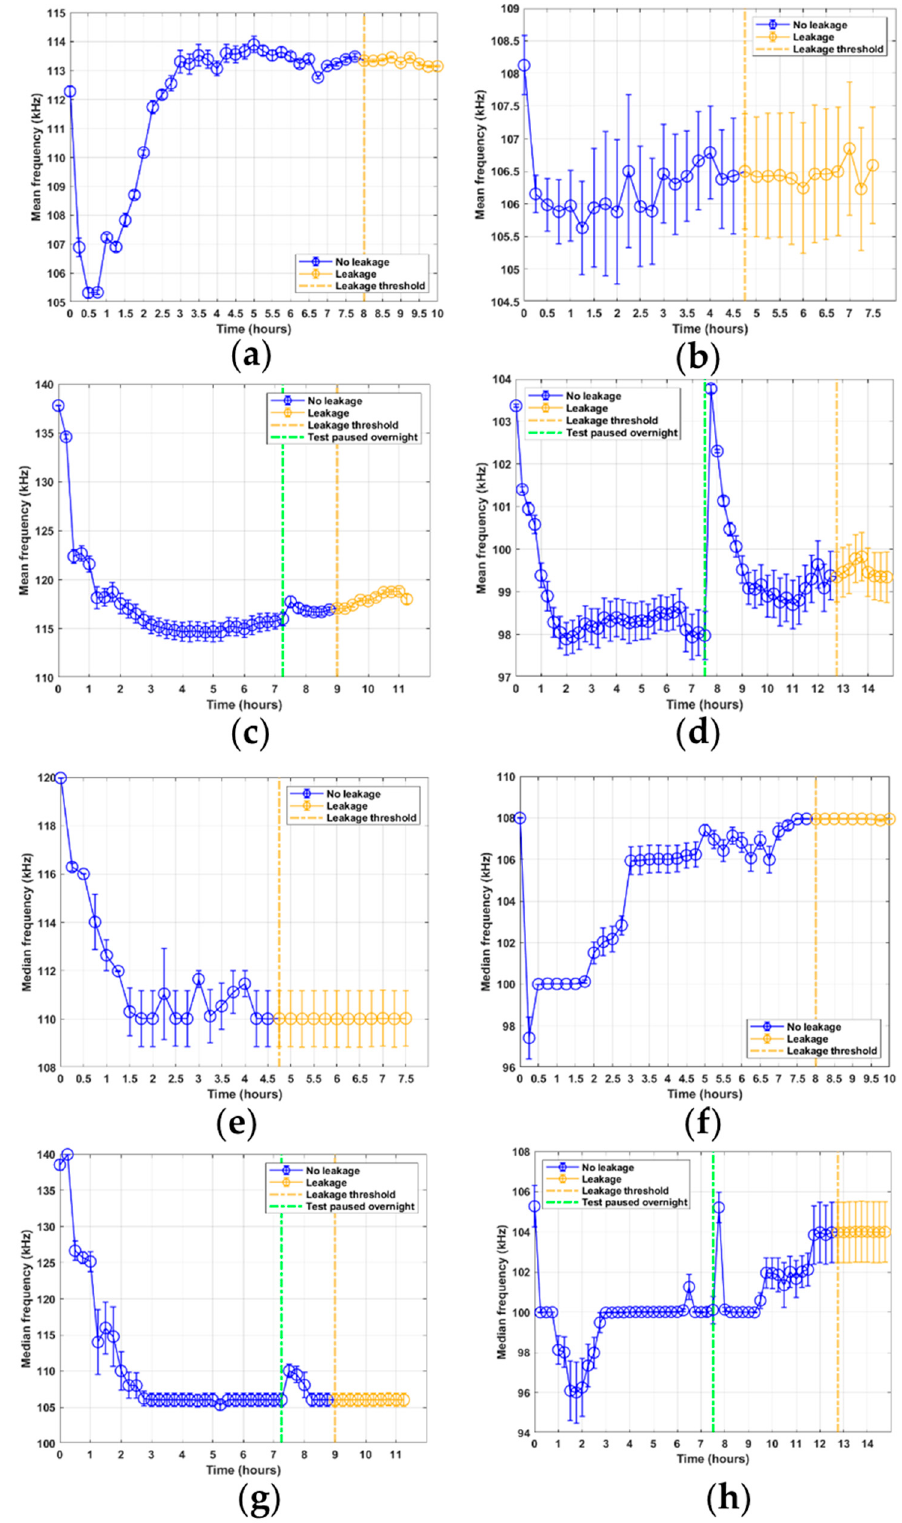
Figure 10. Mean and median frequency feature results from RTF tests 1–4: ( a ) mean frequency, test 1; ( b ) mean frequency, test 2; ( c ) mean frequency, test 3; ( d ) mean frequency, test 2; ( e ) median frequency, test 1; ( f ) median frequency, test 2; ( g ) median frequency, test 3; ( h ) median frequency, test 4.